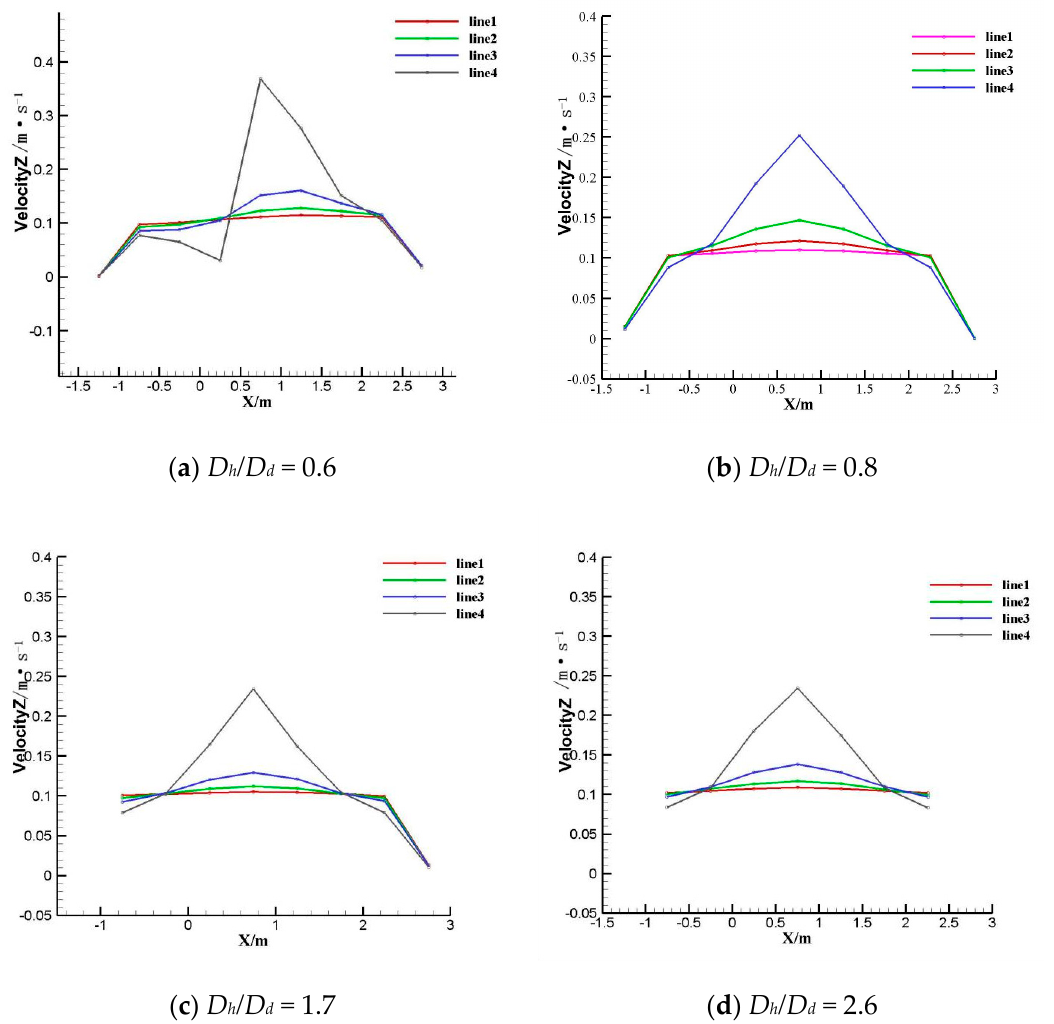
Figure 15. Suction sump multi-axis on the axial flow velocity distribution with different overhang heights.